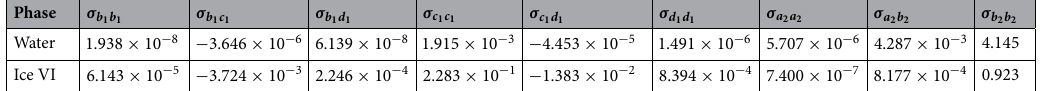
Phase σ b 1 b 1